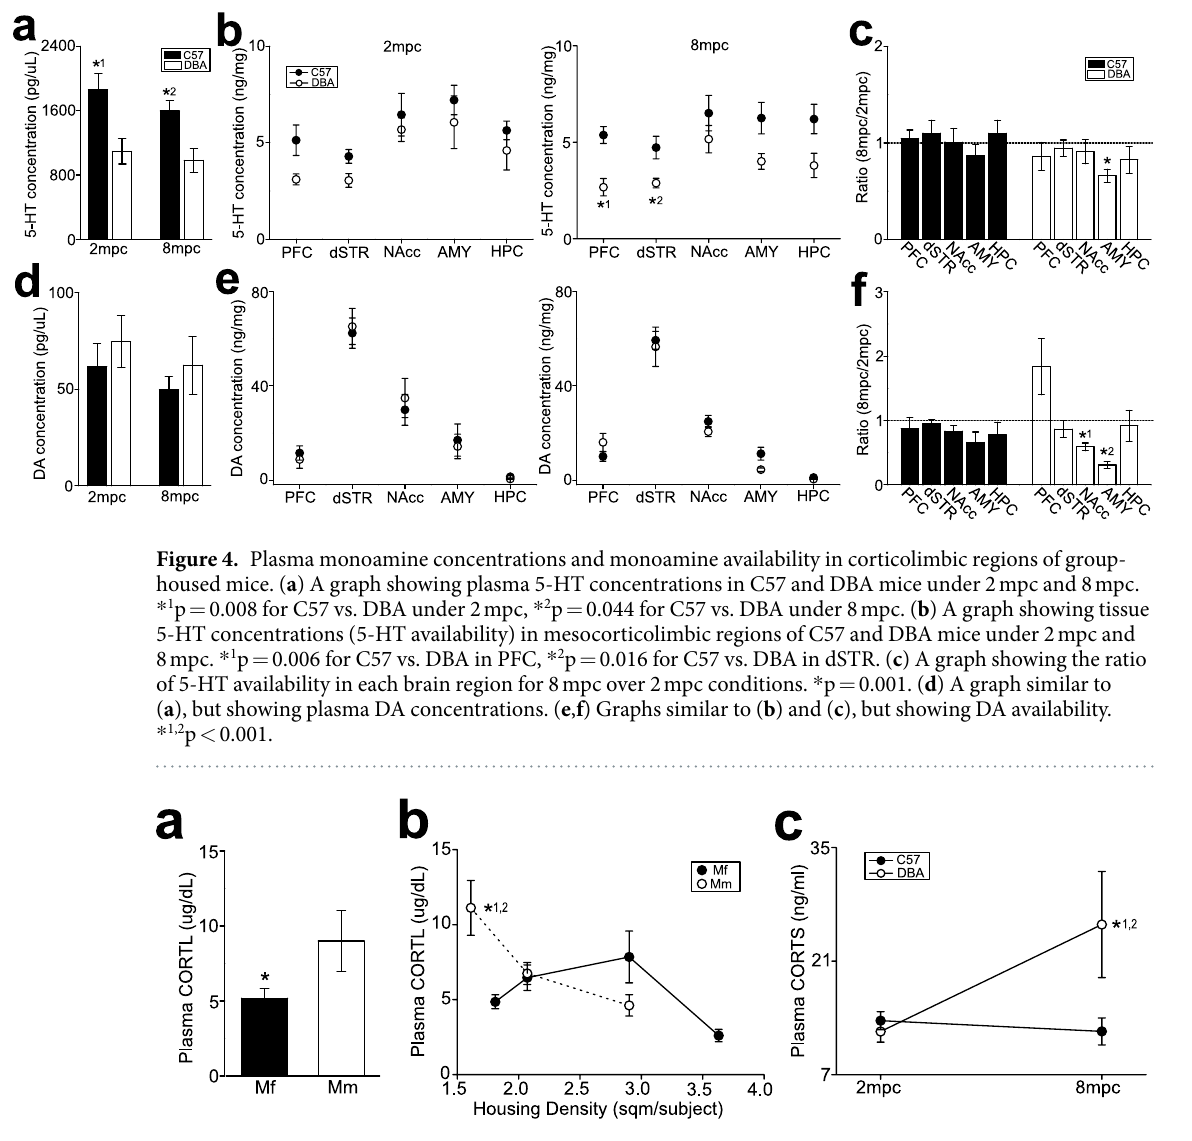
Figure 5. The effects of housing density on plasma stress hormones in rodents and primates. ( a ) A graph showing plasma CORTL concentrations in Japanese and rhesus macaques. * p = 0.027 for Mf vs. Mm. ( b ) A graph showing the relationships between housing density and plasma CORTL concentrations in group-housed Japanese and rhesus macaques. * 1 p < 0.001 vs. Mm2.9, * 2 p < 0.001 vs. Mf1.8. ( c ) A graph showing plasma CORTS in C57 and DBA mice under 2 mpc and 8 mpc. * 1 p = 0.0497 for 2 mpc vs. 8 mpc in DBA, * 2 p = 0.041 for C57 vs. DBA at 8